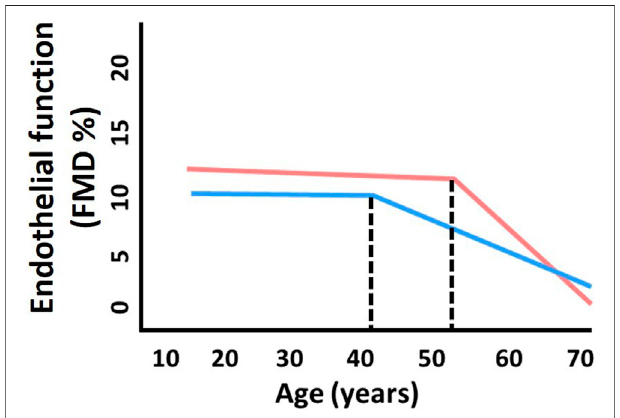
FIGURE 1 | Sex differences in age-related declines in endothelial function. The decline in endothelial function (as measured by fl ow-mediated dilation, FMD) in men (blue) begins around the 4th decade of the life. This in fl ection point is shifted ∼ 10 years later in women (pink) to around